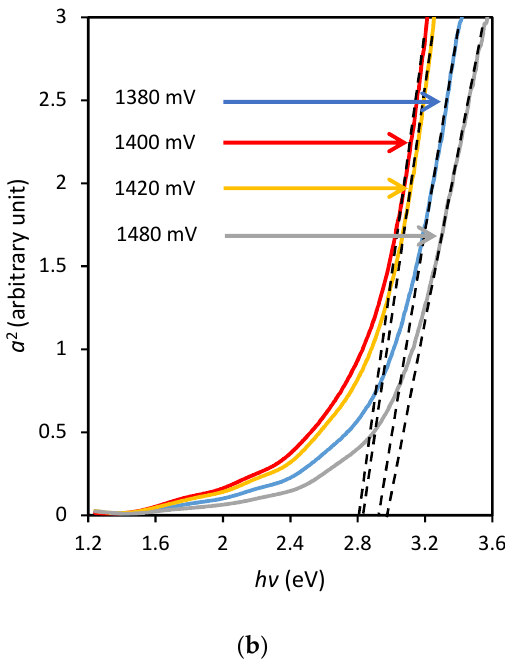
Figure 6. ( a ) Optical absorption ( a 2 vs hv ) plot for samples grown at 1400 mV with different amounts of Mg inclusion in the bath. ( b ) a 2 vs hv plot for samples grown at different growth voltages at high constant Mg concentration in the bath.